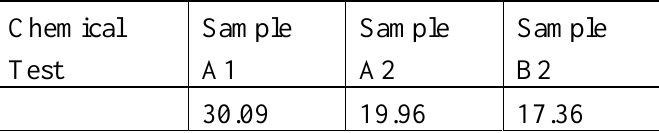
Table 6. Fat content from chemical